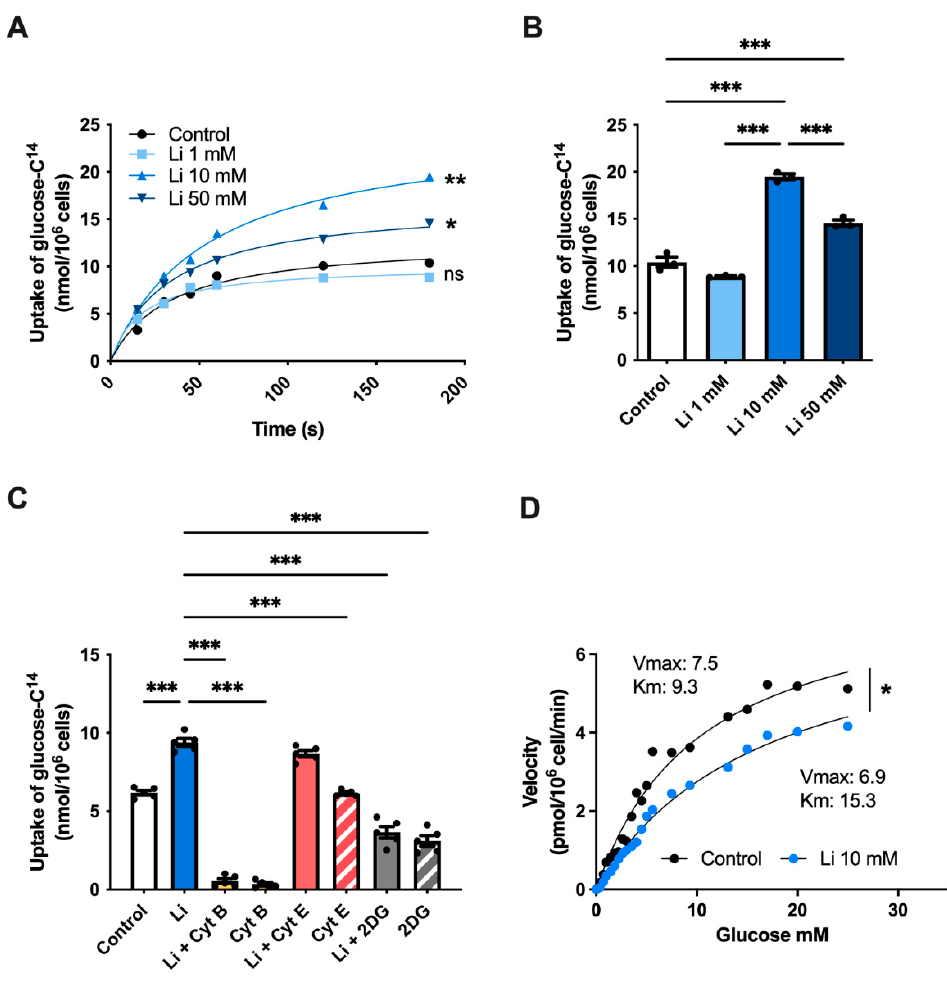
Figure 1. Lithium treatment promotes glucose uptake in hippocampal neurons. ( A ) 14 C-glucose uptake kinetics curve of hippocampal cultures treated with increasing concentrations of lithium measured over 180 s. ( B ) 14 C-glucose uptake at 180 s of ( A ). ( C ) 14 C-glucose uptake competition assay. Hippocampal cultures were treated with 10-mM lithium in the absence or presence of cytochalasin B (Cyt B), cytochalasin E (Cyt E) or 2-deoxy-D-glucose (2DG). ( D ) Michaelis–Menten kinetics of hippocampal neurons incubated with 10-mM lithium and 14 C-glucose for 30 min. Data were analyzed by nonlinear regression and the Michaelis–Menten equation was used to determine kinetic parameters V max and K m . Data plotted as means ± SEM (n ≥ 3 independent cell culture preparations). * p < 0.05, ** p < 0.01, and *** p < 0.001 were determined by one-way ANOVA (in ( B , C )) or two-way ANOVA (in ( A , D )) followed by Bonferroni’s post hoc test for multiple comparisons; ns, not significant.